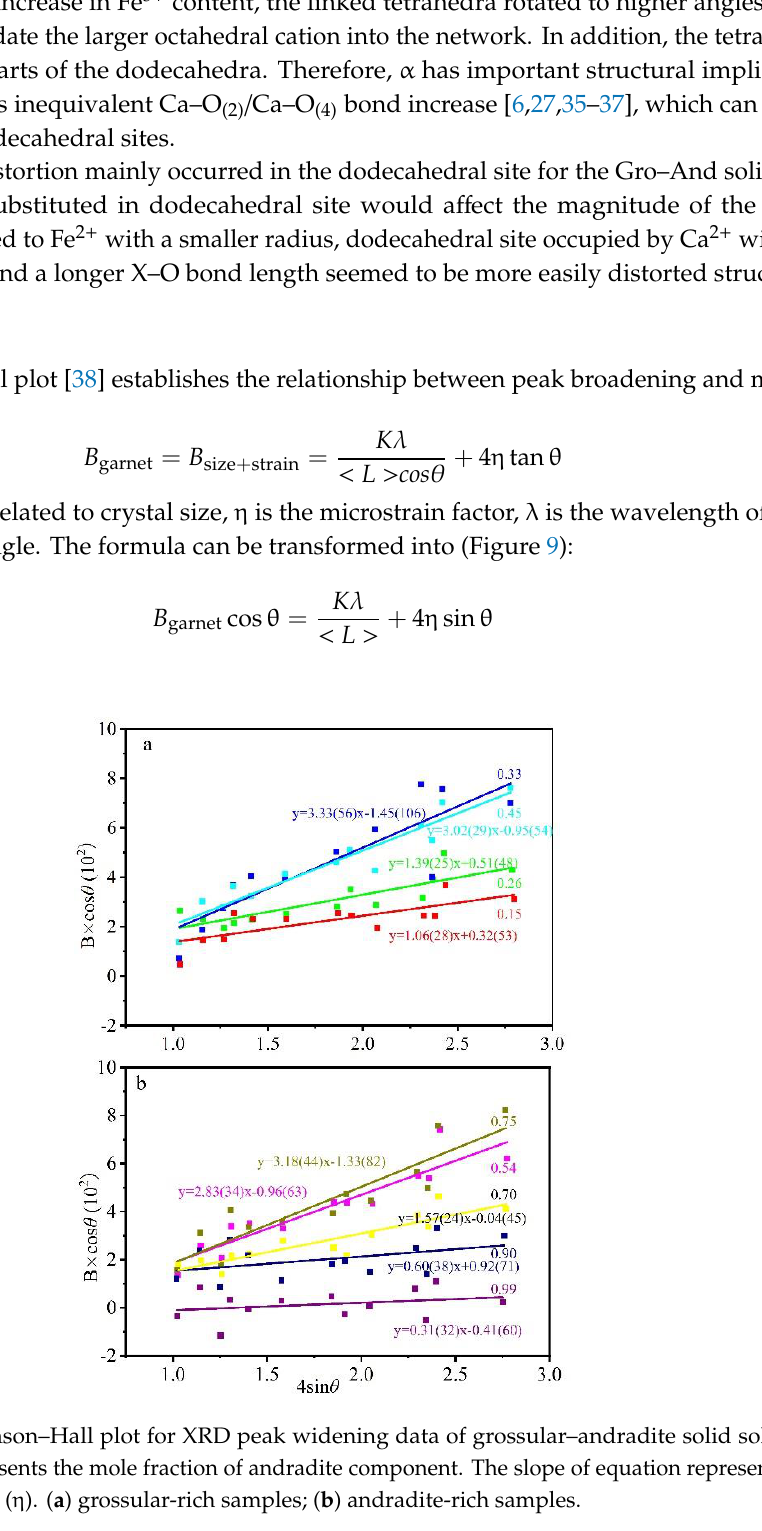
Figure 10. Microstrain inside garnet structure calculated from X-ray peak broadening along the pyrope–grossular join. The size of the microstrain is related to defects [31]. Dapiaggi et al., (2005) [31] proposed that the microstrain in pyrope–grossular garnets may be related to excess enthalpies because elastic strain has an important contribution to mixing enthalpies [39]. However, Becker and Pollok (2002) [40] predicted nearly symmetric positive excess behavior of enthalpies in Gro–And solid solution.